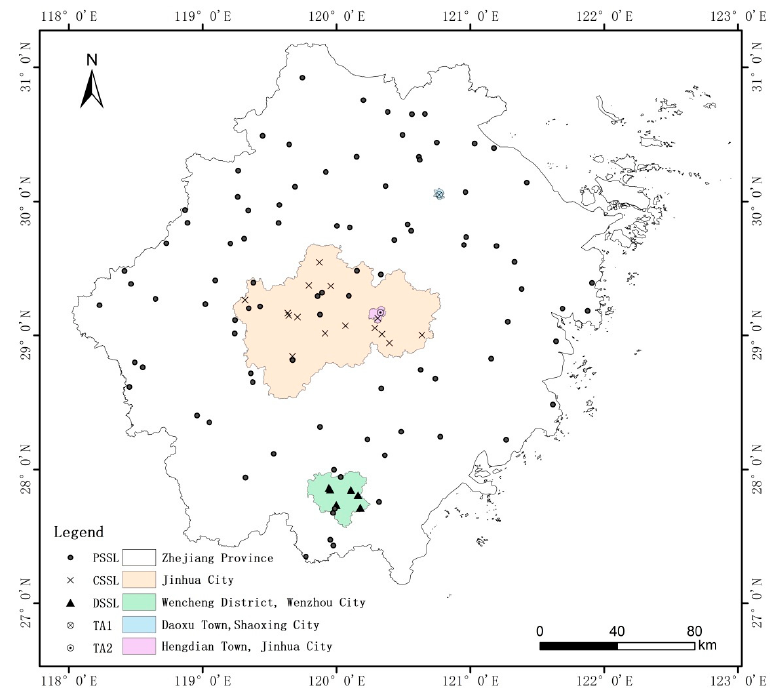
Figure 1. Map of three soil libraries and two target areas, and distribution of sampling points.